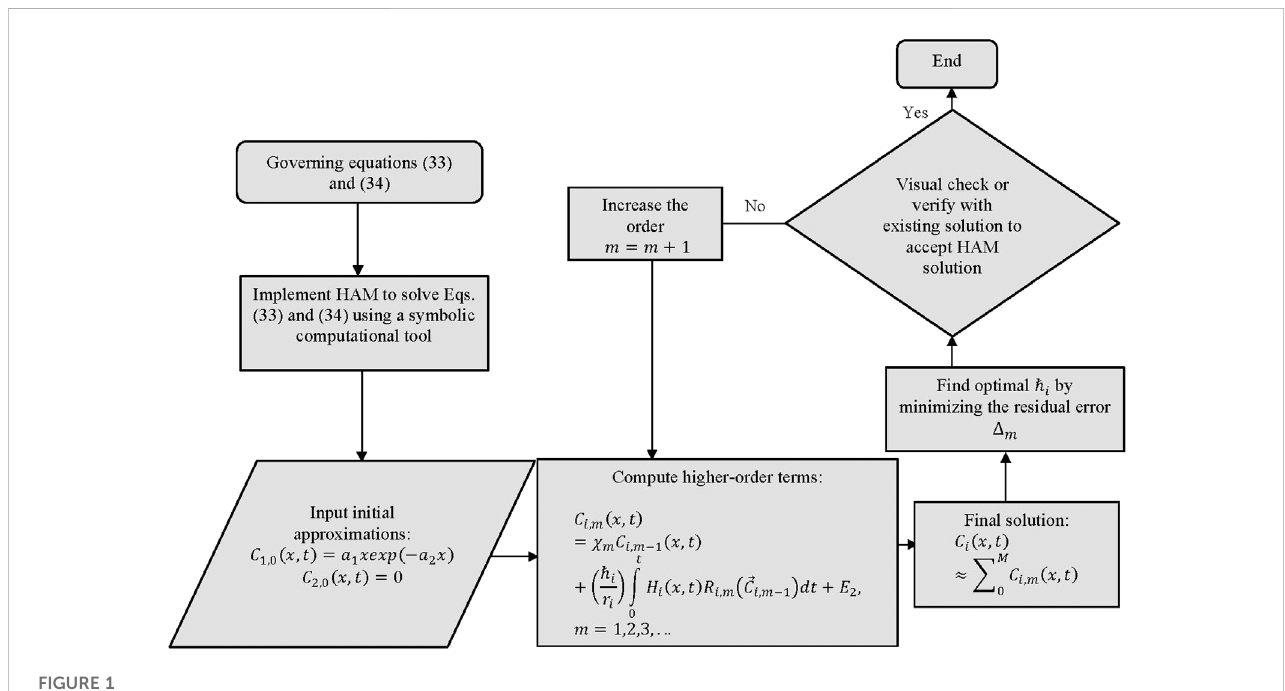
FIGURE 1 Flowchart for the HAM solution